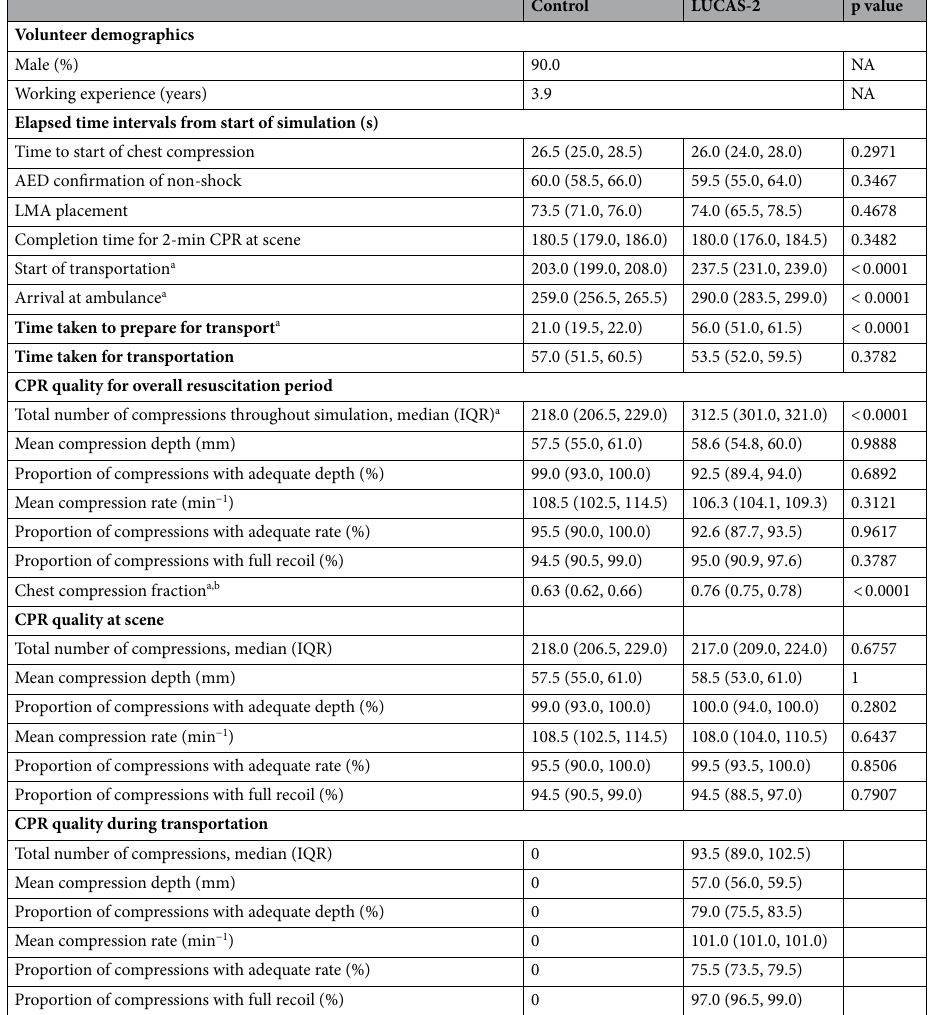
Table 2. Comparison between LUCAS-2 group and control group. AED automated external defibrillator, LMA laryngeal mask airway, CPR cardiopulmonary resuscitation. a Statistical significance. b Chest compression start of chest compression”)/total duration (“time to arrival at ambulance)]. Chest compression fraction for LUCAS group = {[period of CPR at scene (approx. “time to completion for 2-min CPR at scene” −“time to